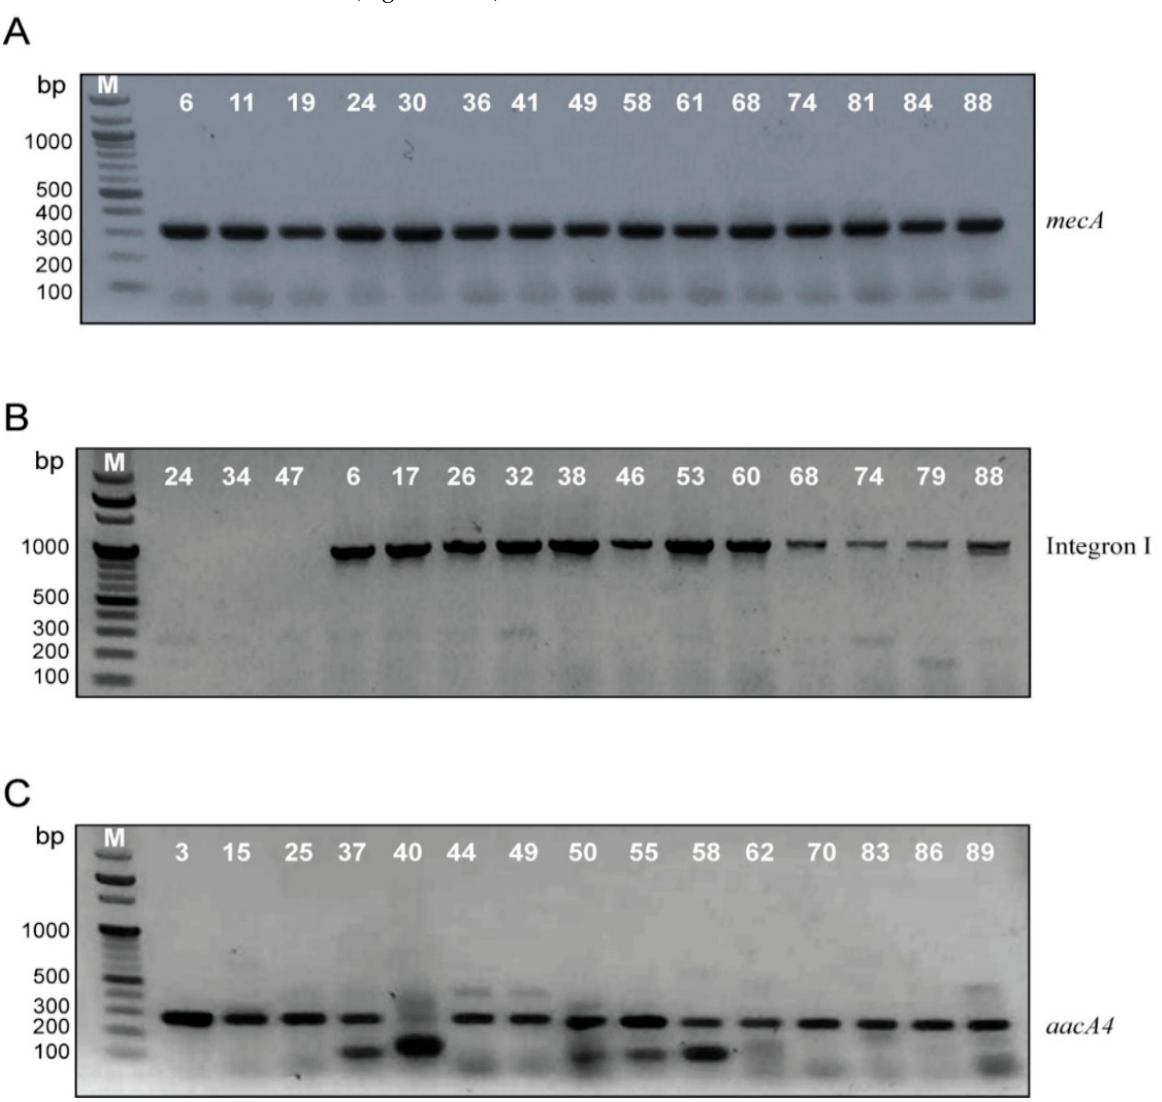
Figure 3. Electrophoretic graph of PCR products on 1.5% agarose gel stained with ethidium bromide for ( A ) mecA gene among S. aureus isolates, positive isolates gave a single band of 310 bp. ( B ) Integron I amplicon among MRSA, positive isolates gave a single band of either 250 bp or 1000 bp. ( C ) aacA4 gene among MRSA, positive isolates gave a single band of 200 bp.